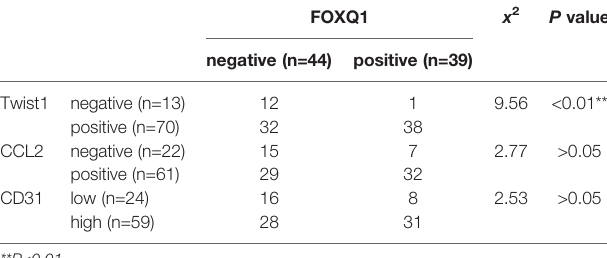
TABLE 2 | Correlation analysis of FOXQ1 and Twist1, CCL2, or CD31 expression in cohort (n=83) colorectal cancer (CRC) tissues.